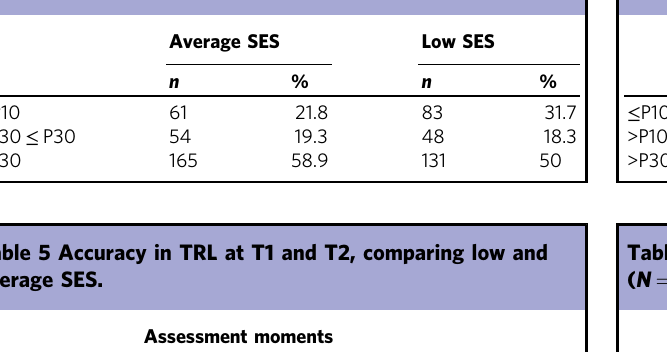
Table 4 Percentile distribution of results in T1, by SES.